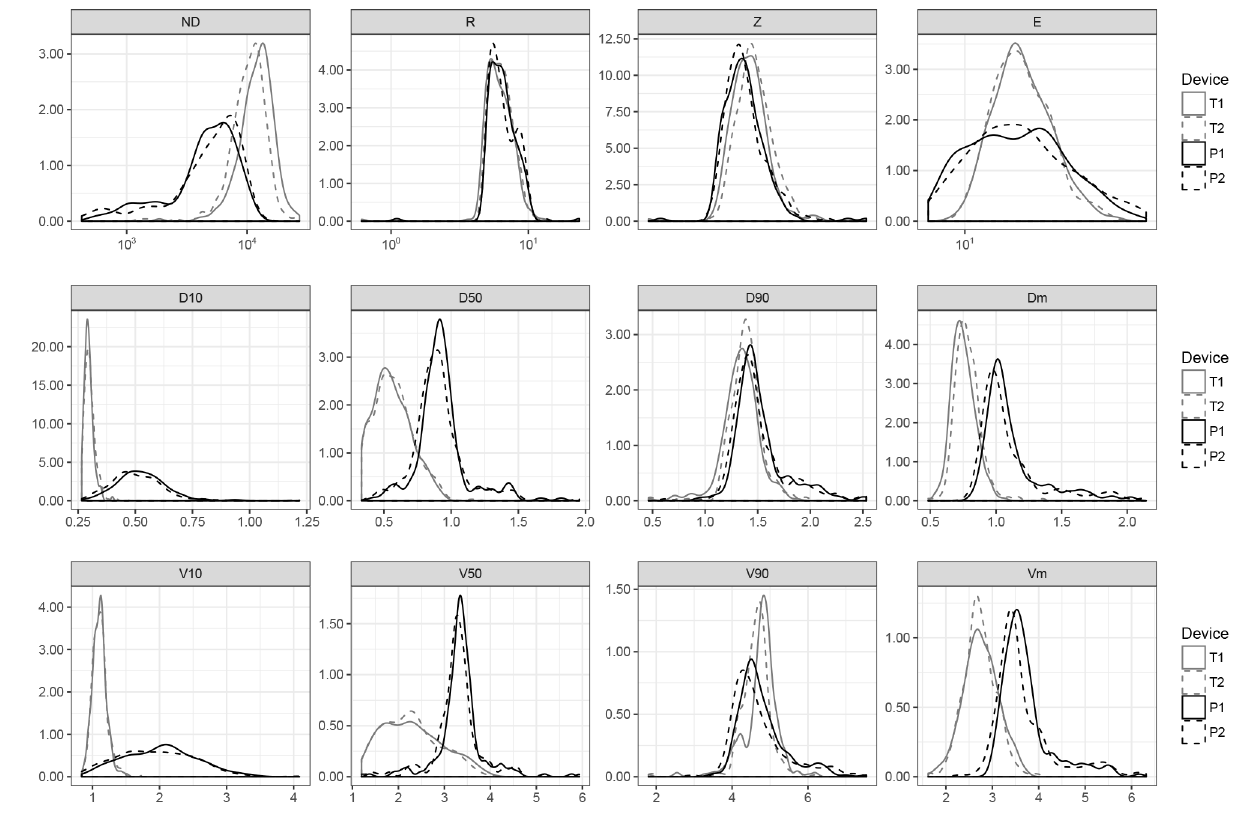
Figure A6. Kernel density plots for high rainfall intensities ( I > 10mmh − 1 ).